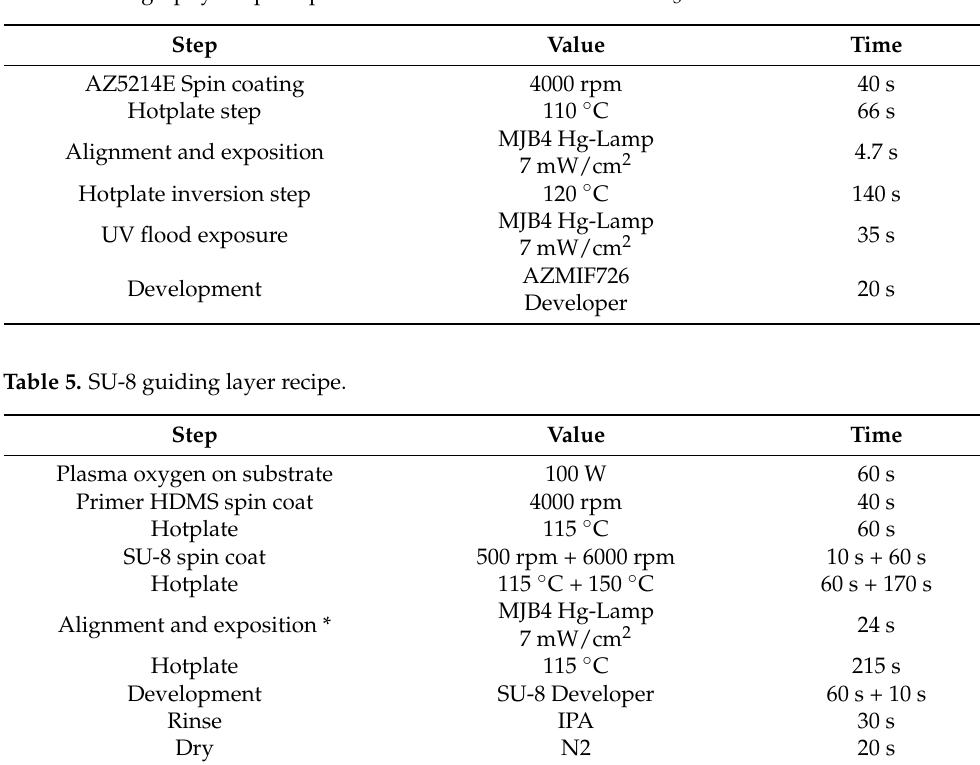
Table 4. Lithography recipe to process the IDTs on a 36Y cut LiNbO 3 substrate.